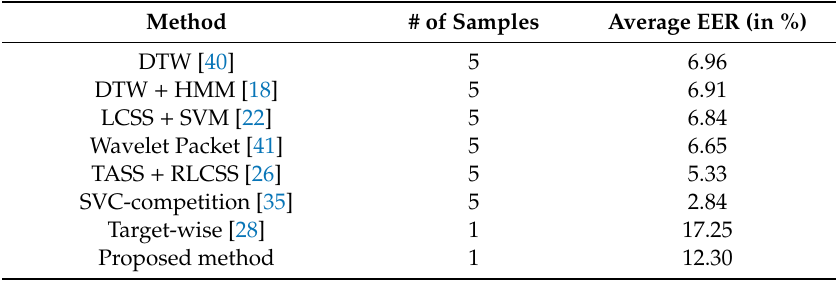
Table 7. Comparative studies of state-of-the-art methods implemented on SVC1.